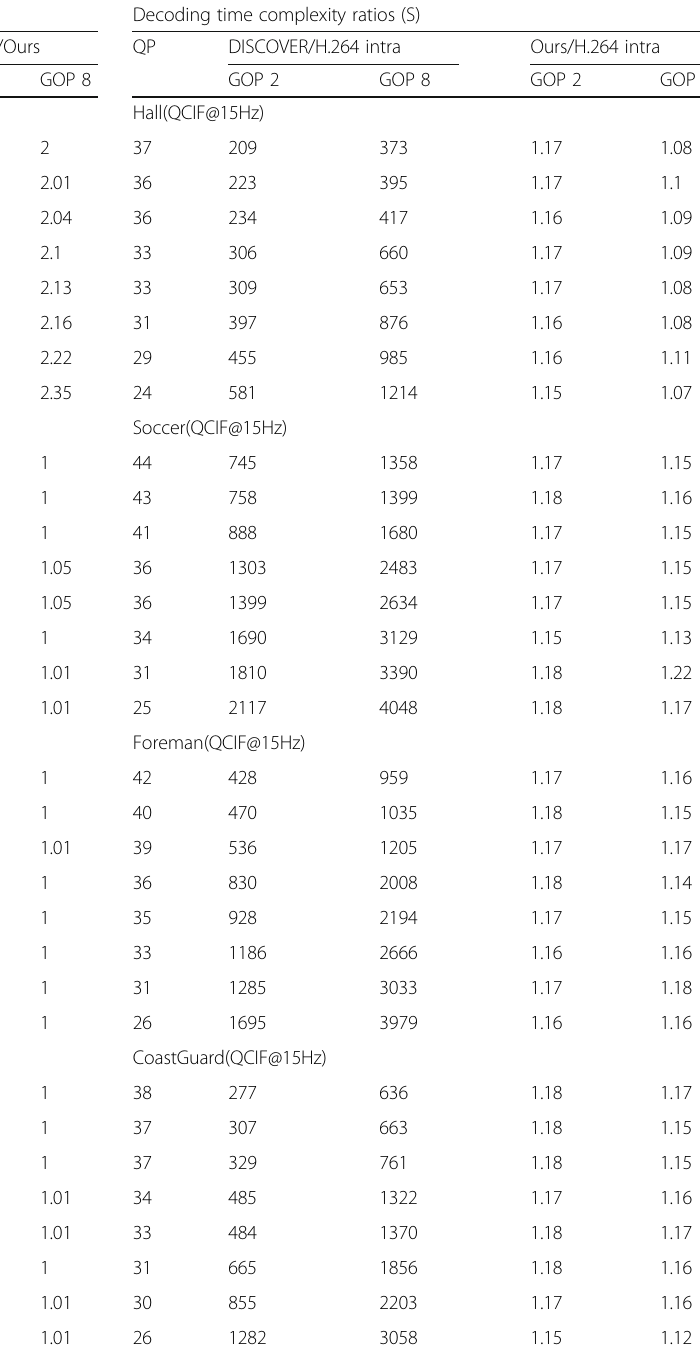
Table 1 The encoder time ratio of the proposed PB-based LVC and DISCOVER codecs